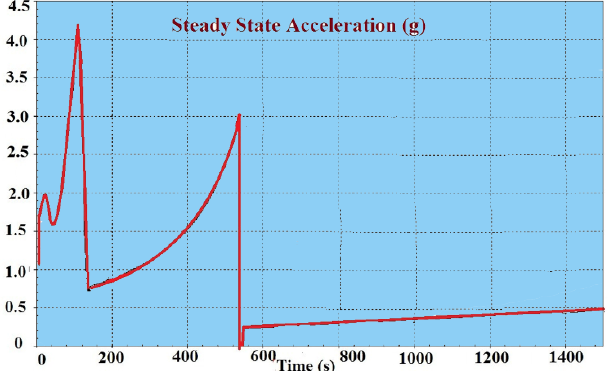
Figure 8. Longitudinal steady state acceleration for the Ariane 5 launch vehicle. Adapted from [7].